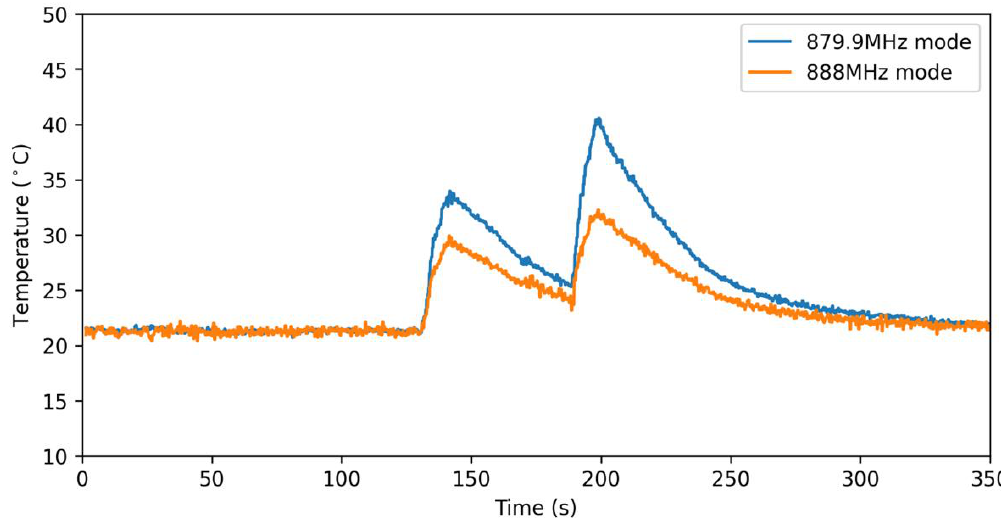
Figure 9. Measured temperature shift in 879.9 and 888 MHz modes in response to two separate heating periods. Before the first heating event, the temperature of the resonators (each correlating to an individual mode) was identical, and, following the second cool-down period, the temperature of the modes converged.